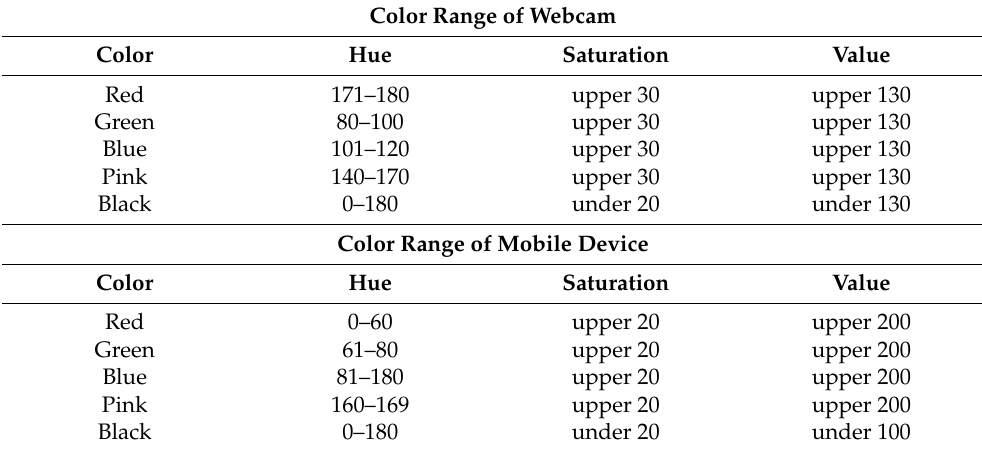
Table 1. Color ranges of webcam and mobile